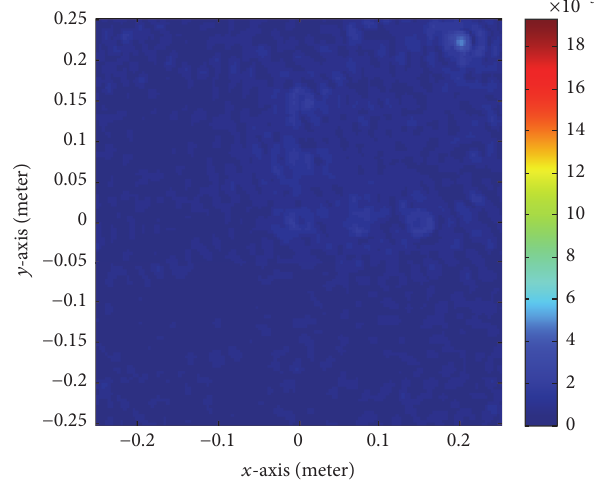
Figure 21: Final tomographic image reconstruction for noisy extended complex target geometry produced by the algorithm, isolating the effect of the weak